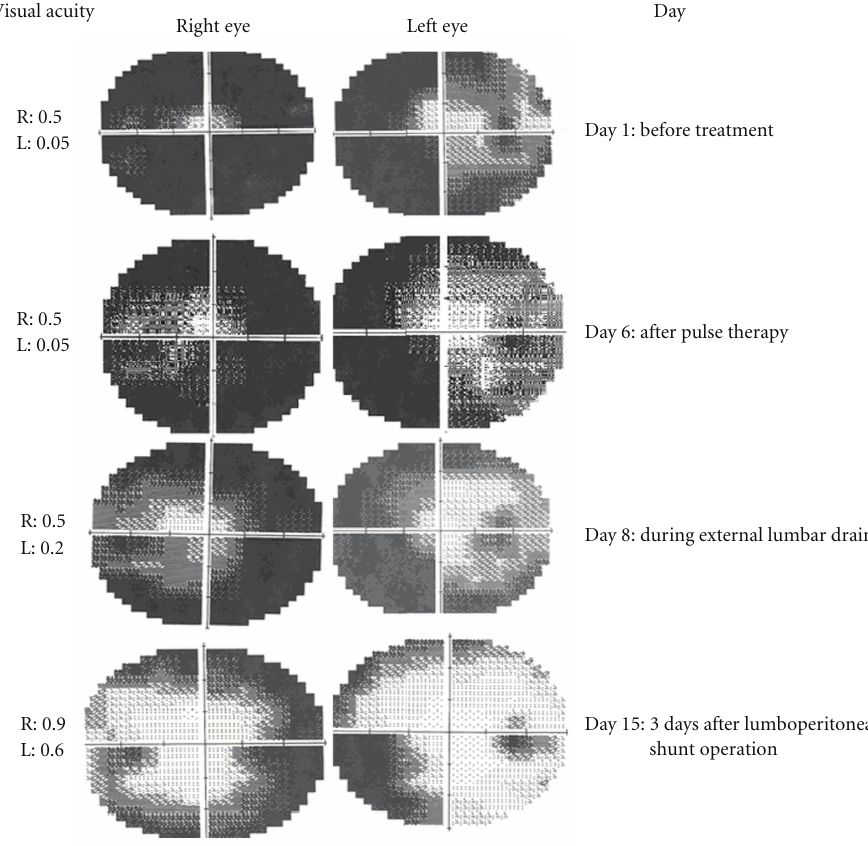
Figure 1: The results of patient’s visual field examination and corrected visual acuity according to the day of